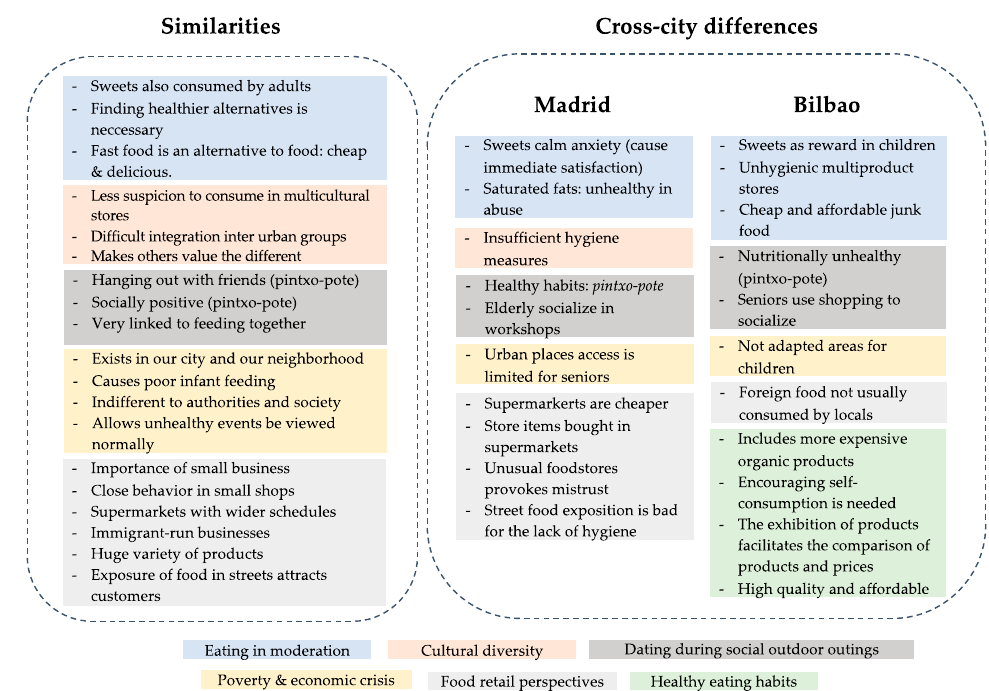
Figure 7. A Cross-city comparison according to the broader themes and the neighborhoods of Madrid and Bilbao made by the authors.